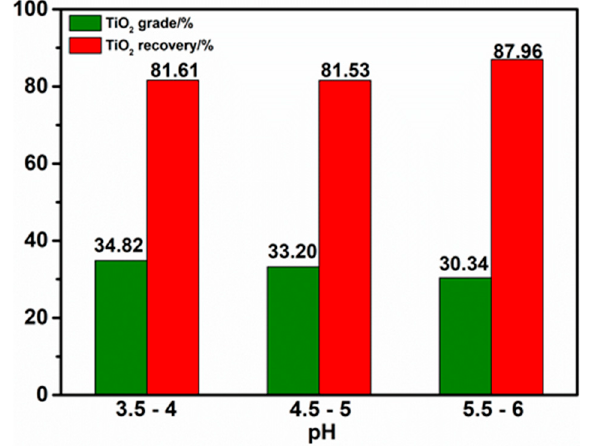
Figure 5. Flotation indexes of synthetic mixtures of minerals (21.2% TiO 2 ) using BS-12 (6.0 × 10 − 5 mol/L) as the collector, at different pH values.